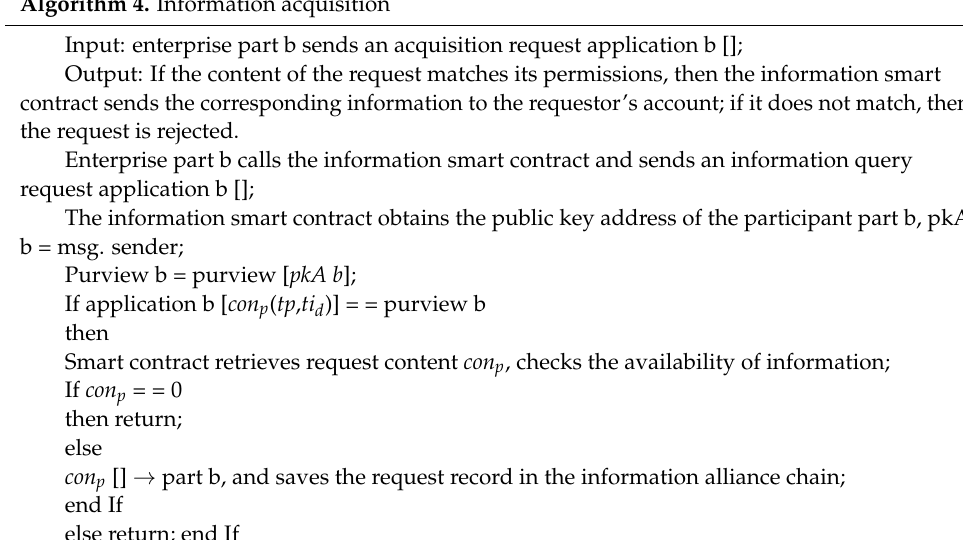
Algorithm 4 Information acquisition Algorithm 4. Information acquisition